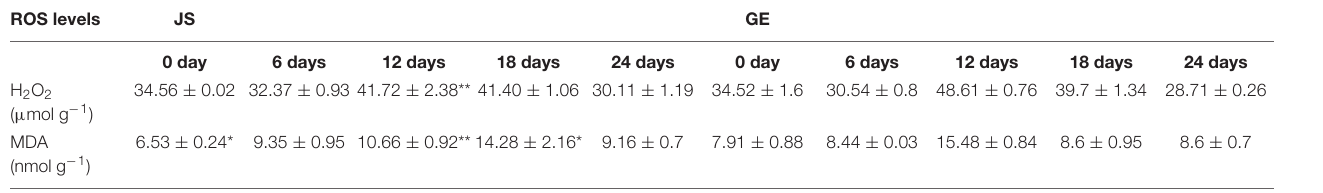
TABLE 2 | Reactive oxygen species levels in JS and GE at different storage periods a .